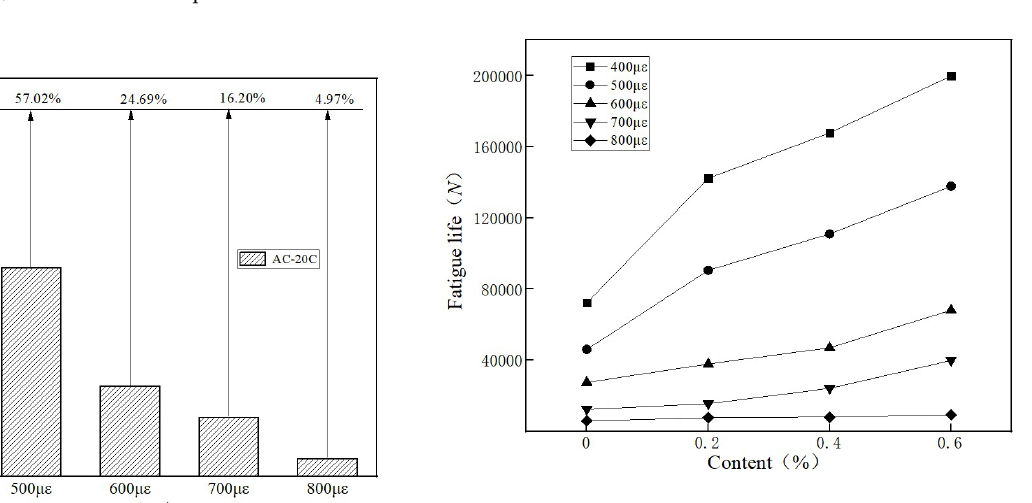
Fig. 3. Relationship between strain and fatigue